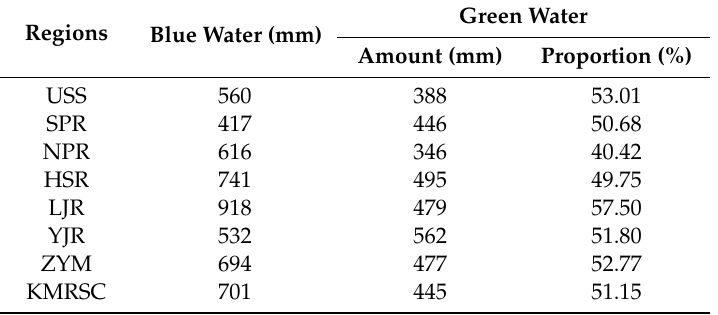
Table 6. Annual average blue water and green water in the Class III WRRs and KMRSC.